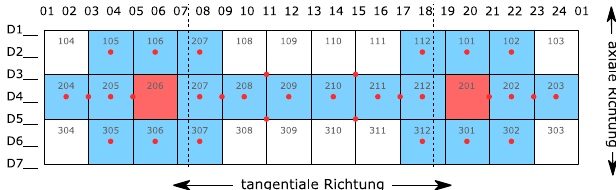
Fig. 6. Sketch of configuration 4). Detectors are positioned in the segment centers within the measurement plane and above and below the segments adjacent to the segment in front of the HPGe-detectors. For better reconstruction of the flux in the most important segments in front of the HPGE-detector additional detectors were added in the neighboring segments.